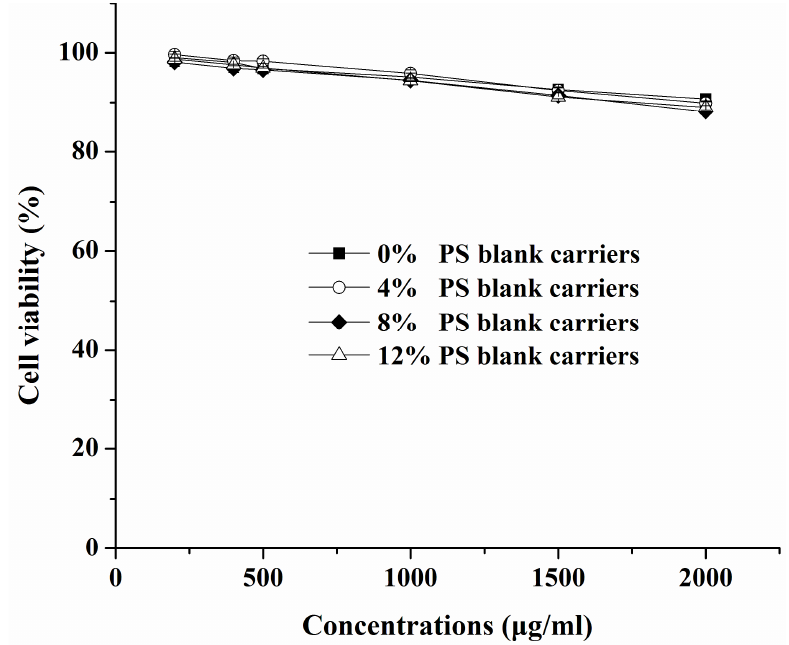
Figure 4. In vitro cytotoxicities of blank carriers with different PS amounts (0%, 4%, 8%, and 12%) at concentrations ranging from 200 to 2000 μ g/mL. Blank carriers were non-toxic in the concentrations of 200–500 μ g/mL, and the cells’ viability was decreased as the carriers’ concentrations increased (mean ± SD, n = 3). All preparations showed negligible cytotoxicities without significant differences between groups ( p > 0.05).